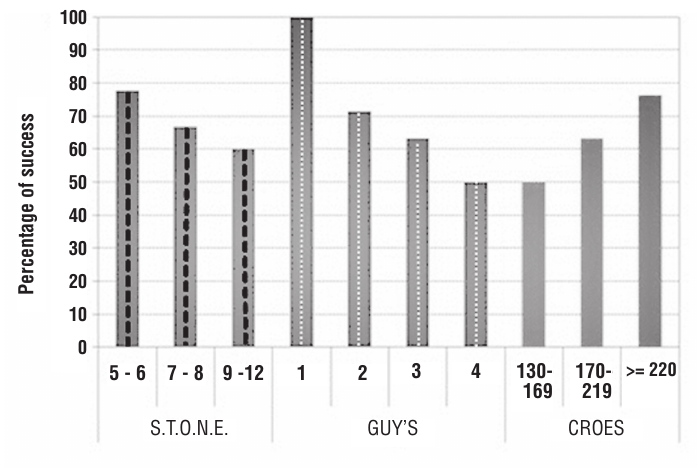
figure 2 – percentage of success by groups of